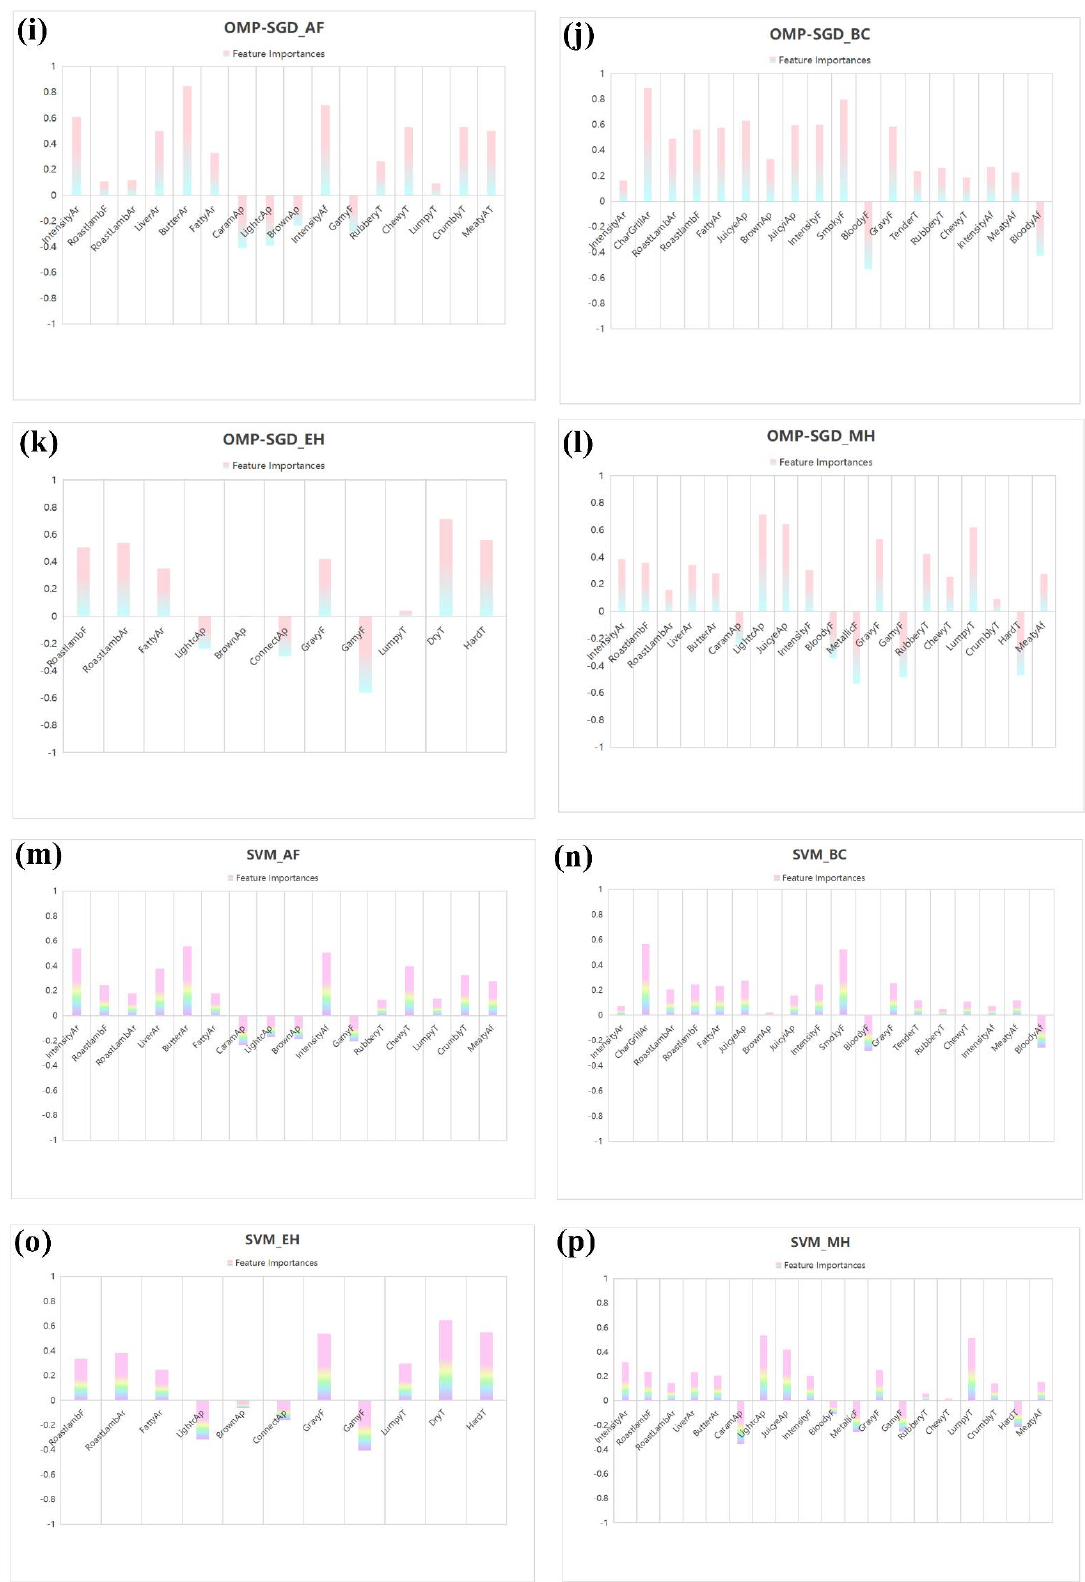
Figure 3. Important variables of the machine learning methods deep neural network ( a – d ), gradient boosted trees ( e – h ), orthogonal matching pursuit—stochastic gradient descent ( i – l ), and support vector machine ( m – p ).